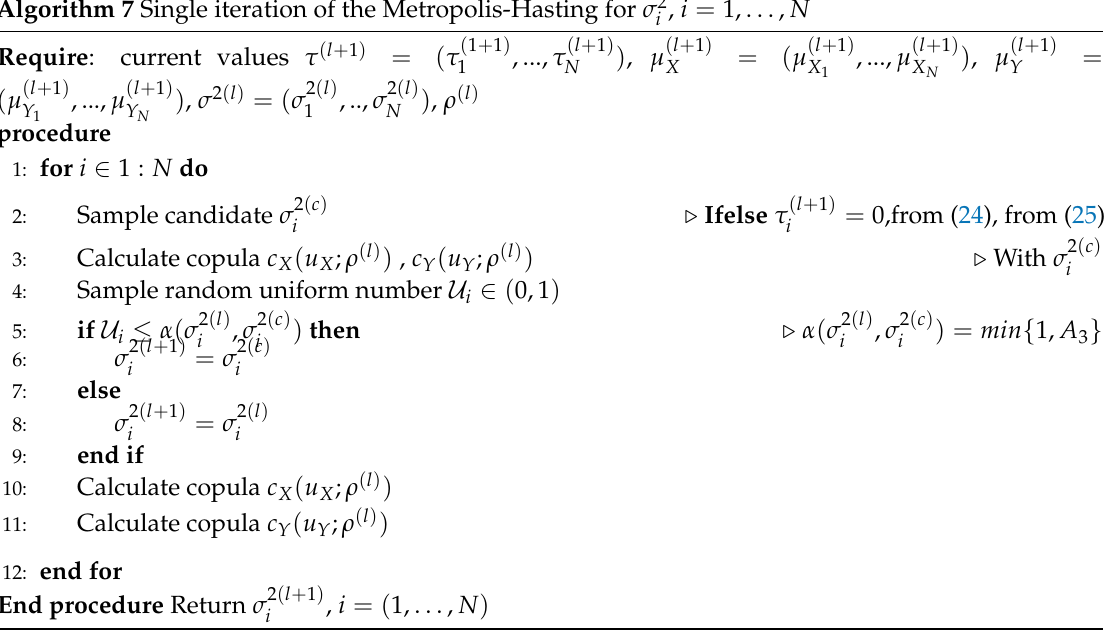
Algorithm 7 Single iteration of the Metropolis-Hasting for σ 2